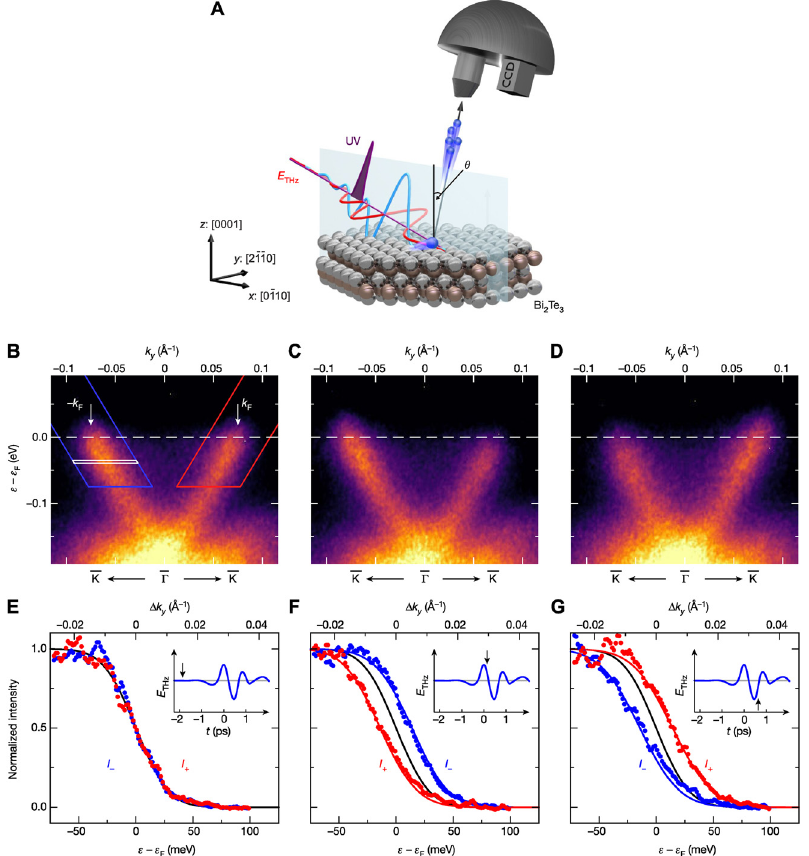
Figure 6: Light-wave-driven THz currents in topological insulator Bi 2 Te 3 . (A) An intense picosecond THz pulse red waveform, s- polarization; blue waveform, p-polarization) interacts with surface state electrons in Bi 2 Te 3 . A femtosecond time-delayed UV- pulse (violet) photoemits the surface electrons.Inthisway,snapshotsofthetime- resolvedbandstructurearereconstructedas function of the THz pump fi eld. (B) Photoemission map before the arrival of the THz fi eld. The topological surface state shows a linear dispersion. (C) The fi rst positive peak of the THz pulse accelerates the electron distribution towards − k. (D) The negative peak of the THz pulse accelerates the electron distribution towards + k . (E) – (G) Intensity distributions along the left (blue circles)andright(redcircles)branchesofthe Dirac cone, respectively. Insets: reconstructed electric fi eld, with the black arrows indicating the delay times of the corresponding photoemission